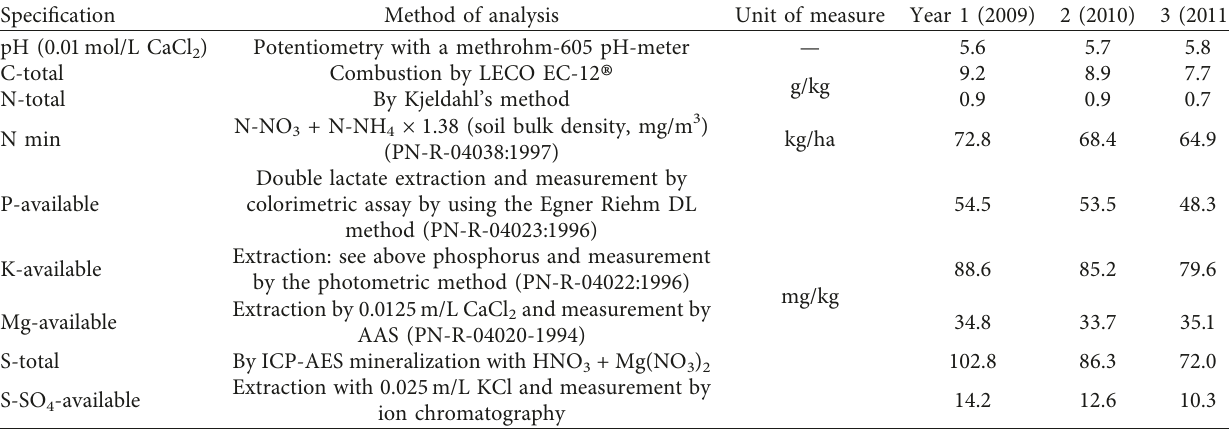
Table 3: Chemical characteristics of the soil (before sowing).